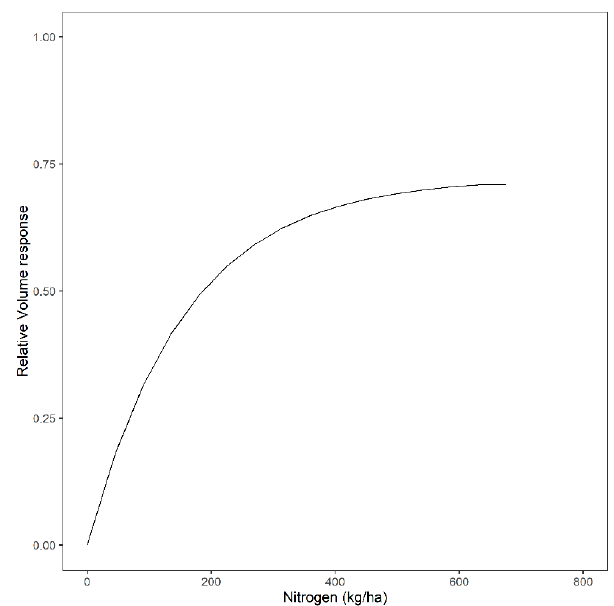
Figure 3. Hypothetical relative volume response for different levels of nitrogen (kg ha − 1 ).